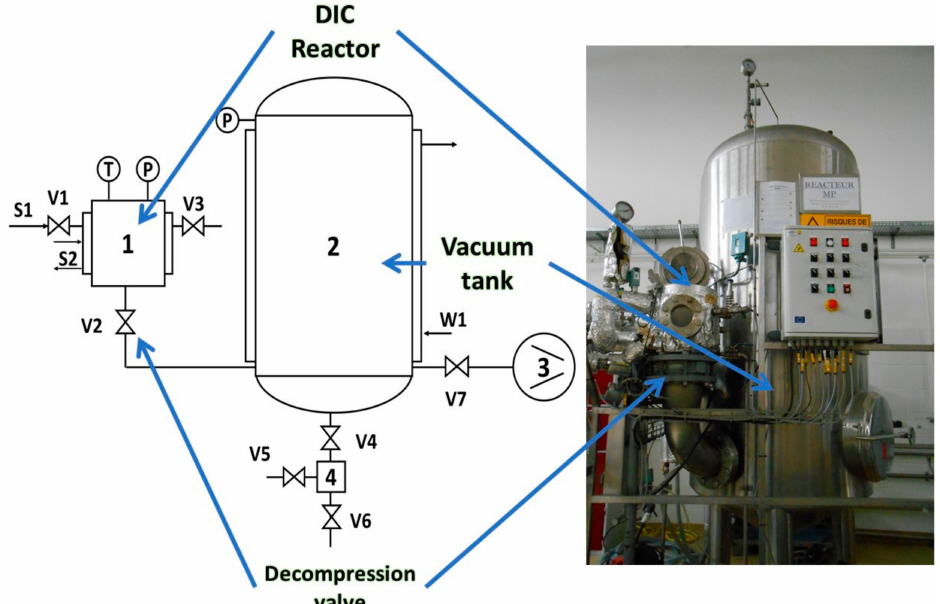
Figure 3. Left: Schematic diagram of DIC Equipment: (1) DIC reactor; (2) vacuum tank; (3) vacuum pump; (4) Trap, V1-V7-valves, S1, and S2 saturated steam injection, W1- cooling water. Right: Laboratory DIC equipment (ABCAR-DIC Process, Compi è gne,